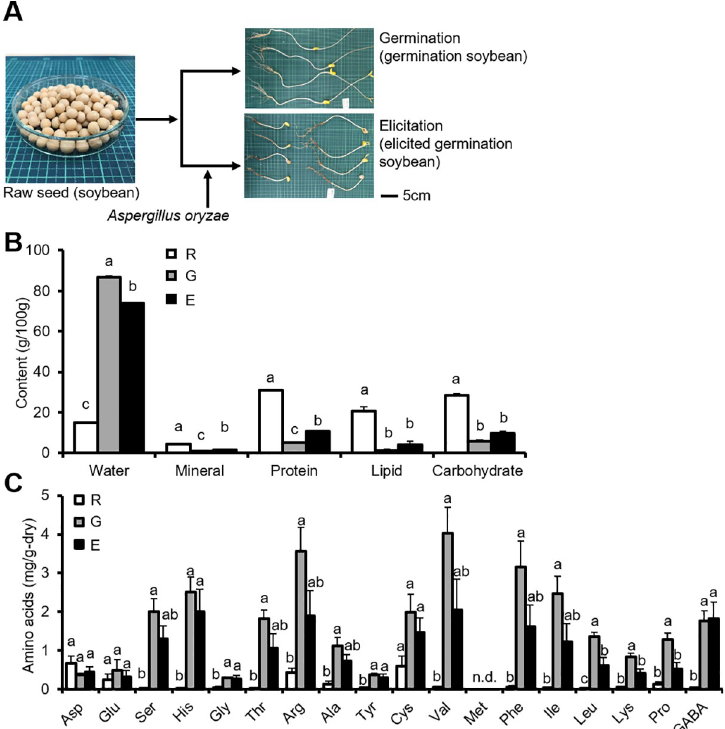
Fig 1. Effects of germination and elicitation on water and nutrient content of soybean. (A) Processes of germination and elicitation in soybean. (B) Water, protein, lipid, mineral, and carbohydrate content of raw seed, germination, and elicitation samples. (C) Amino acid content of raw seed, germination, and elicitation samples. Data are expressed as means ± SEM (B: n = 5 /group; C: n = 3 /group). Different letters indicate significant differences ( p < 0.05). R: raw seed (soybean); G: germination (germinated soybean); E: elicited germinated soybean. n.d.: not detected.